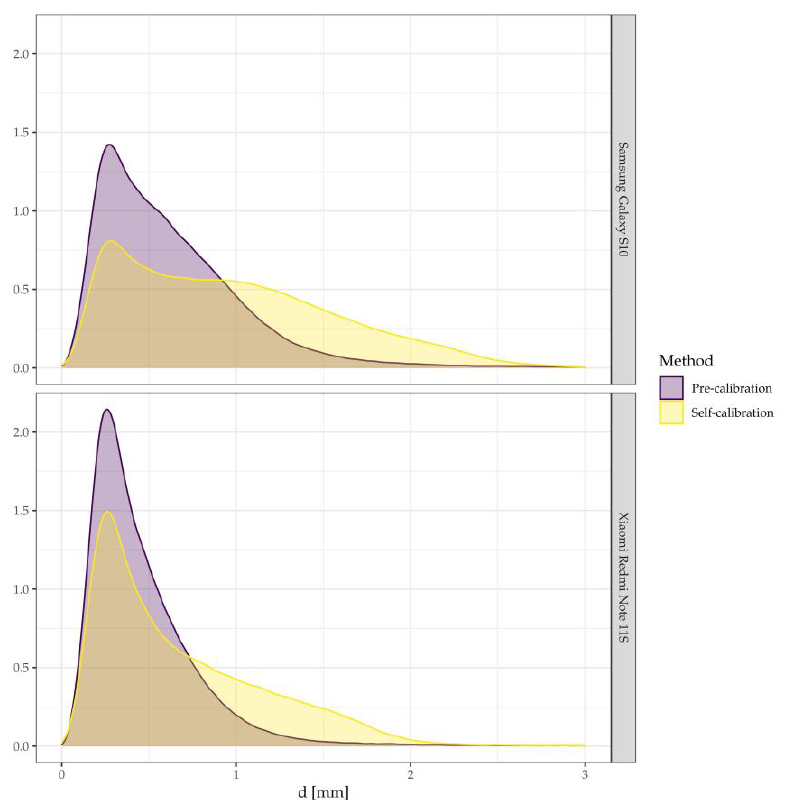
Figure 4. The density plot of the distances between 3D models. SPC’s in relation to the reference model.